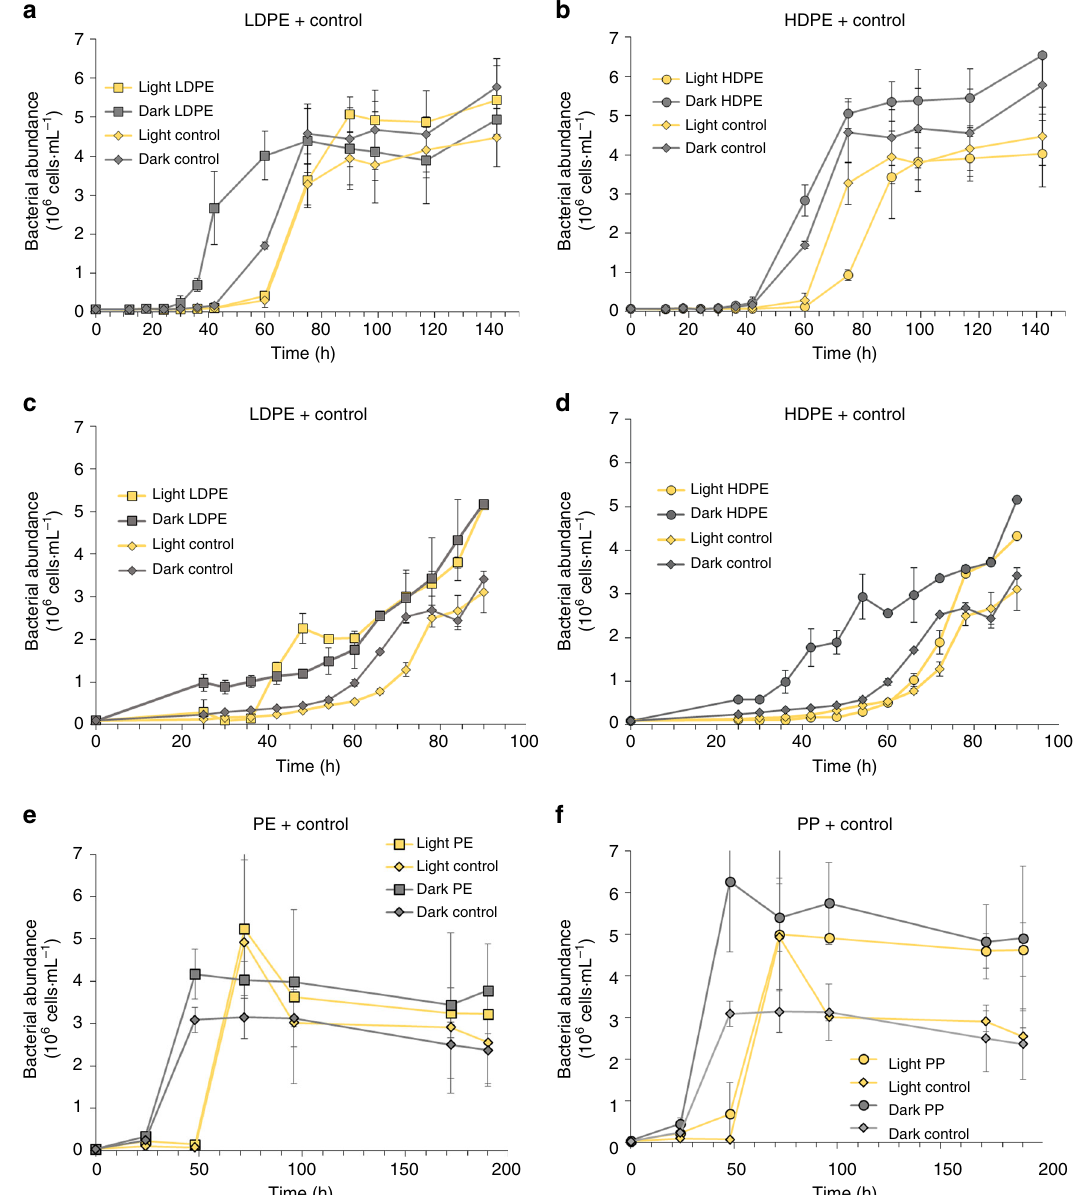
Fig. 2 Bacterial abundance during incubation with plastic leachates. Bacterial abundance (cell mL − 1 ) during the incubation with DOC leached from plastics previously irradiated for 6 days using a LDPE and b HDPE; for 30 days using c LDPE and d HDPE; for 30 days using e PE and f PP. Error bars represent the standard deviation of the mean of the triplicate cultures. HDPE high-density polyethylene, LDPE low-density polyethylene, PE polyethylene,